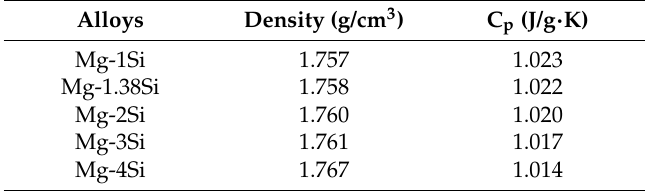
Table 1. Room temperature density and calculation of the specific heat capacity of Mg–Si binary alloys.